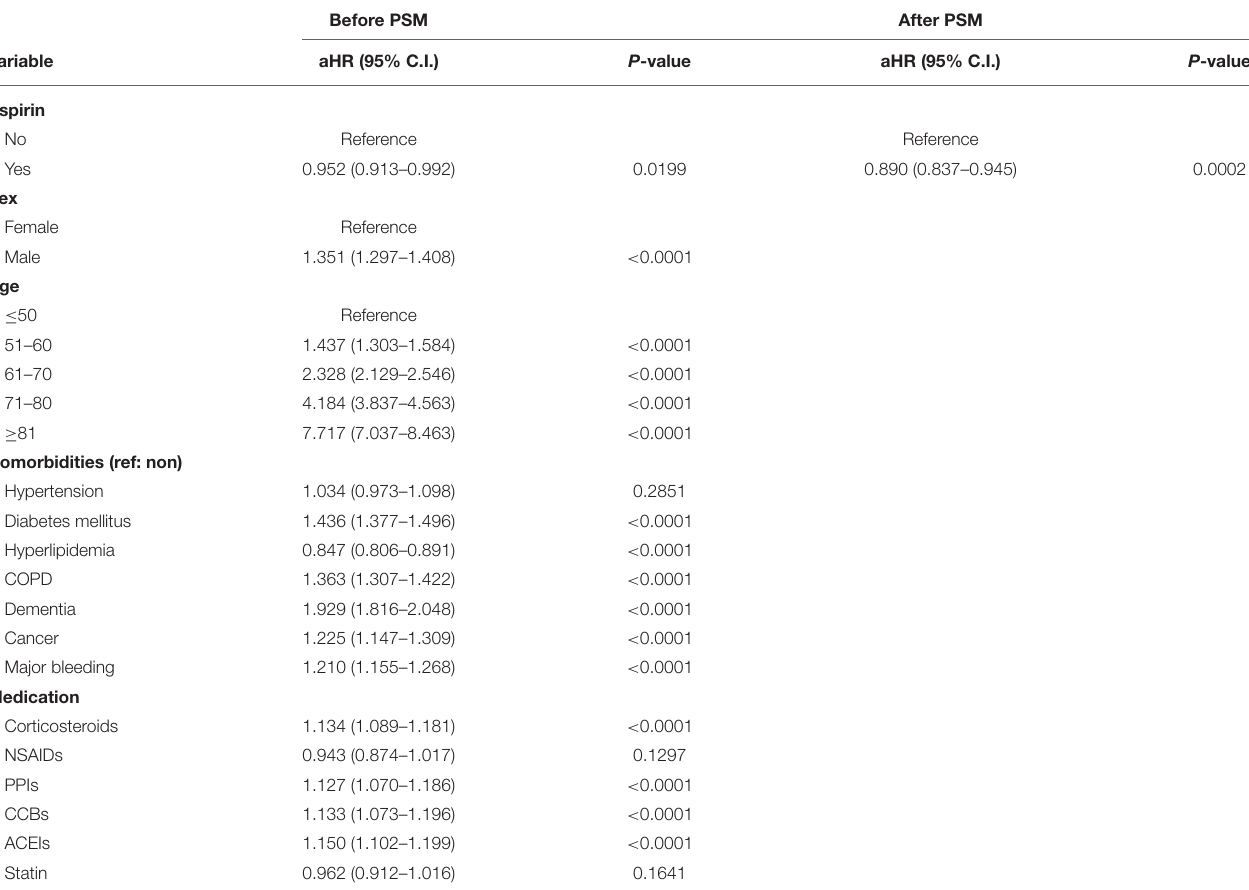
TABLE 2 | Multiple Cox proportional hazard regression results for